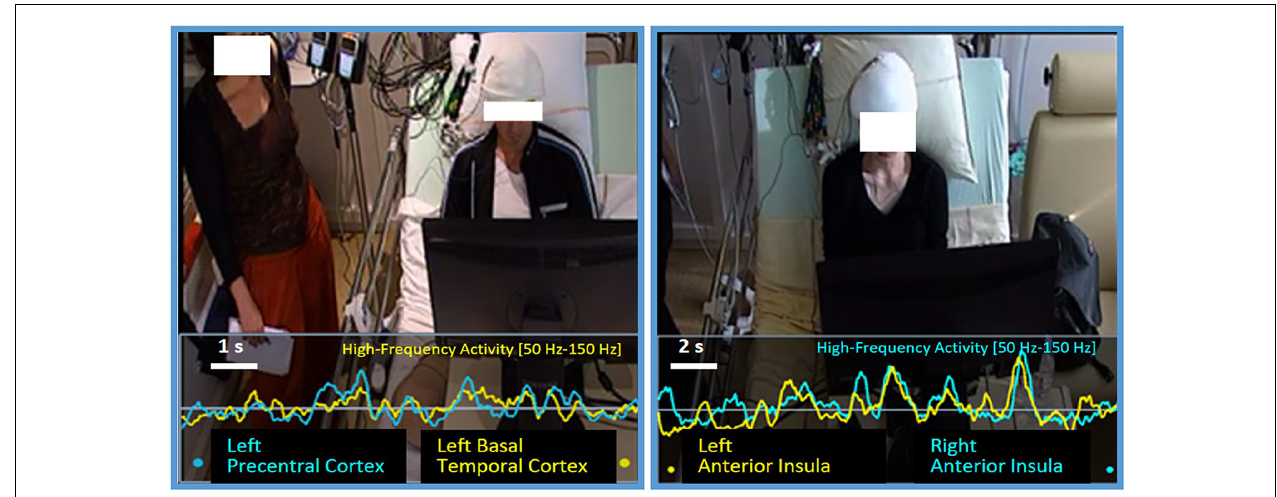
FIGURE 11 | Correlation between bottlenecks. BrainTV display showing episodes of very high and sustained correlation between two bottlenecks: on the left image, patient P4 presents a first bottleneck in the left Precentral Cluster (teal line), and a second one in the left Basal Temporal Cluster (yellow line). Curves correspond to HFA activity measured in the last 10 s before a verbal VFT response. On the right image, we observe patient P11 with the same representation, showing a robust correlation between two sites in the left and right Anterior Insulae. Curves correspond to HFA activity measured in the last 20 s before a verbal VFT response.